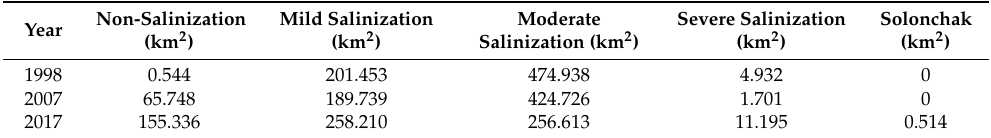
Table 6. Statistics of Saline Soil Area in Shouguang from 1998 to